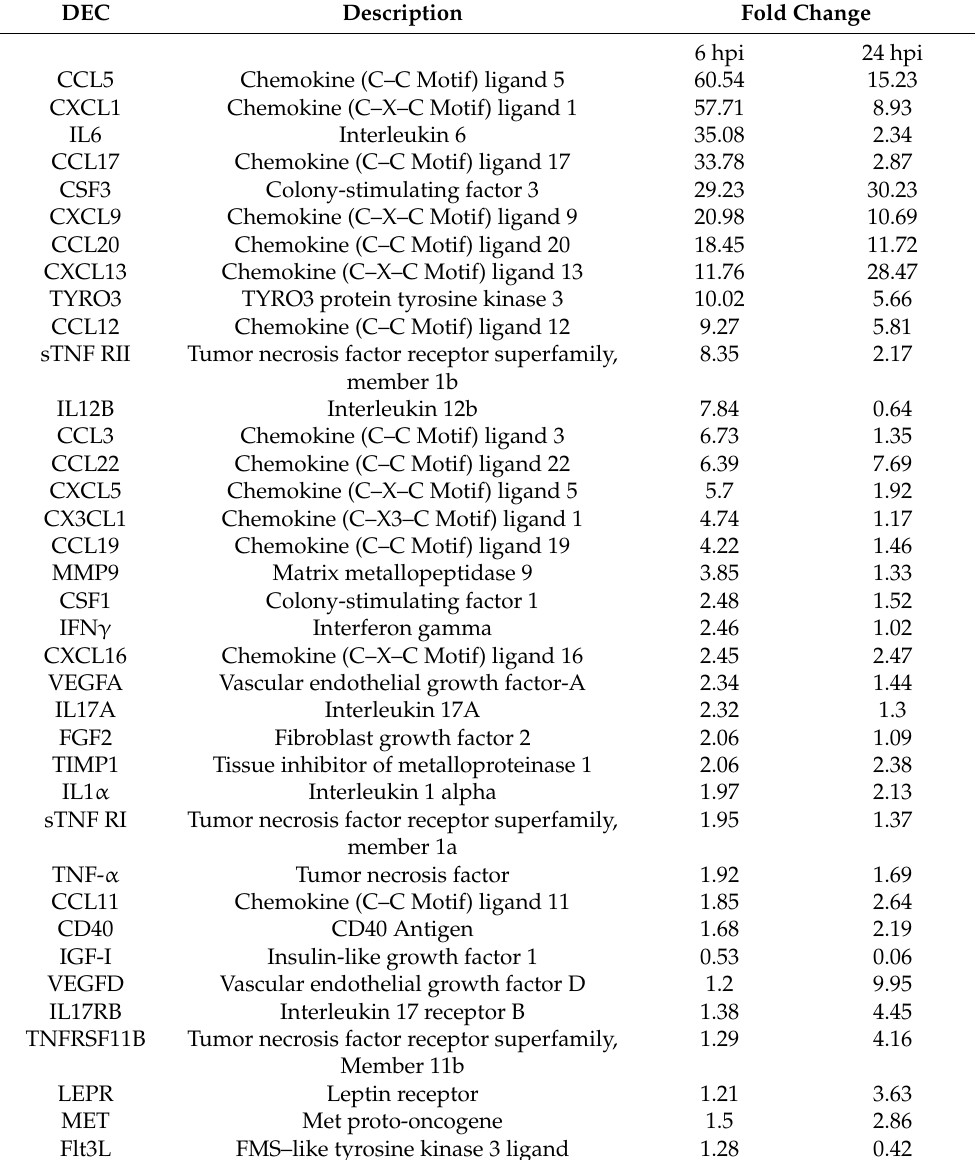
Table 1. Fold change (infected/uninfected group) of the DECs at 6 and 24 h post-infection